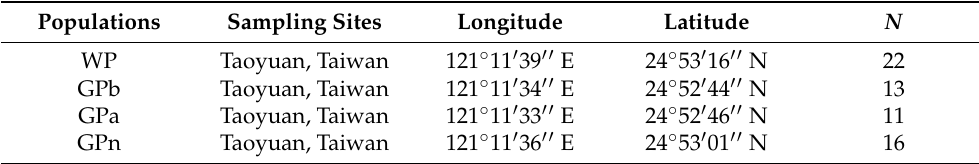
Table 5. Sampling sites of the four Nuphar shimadai populations in northern Taiwan.